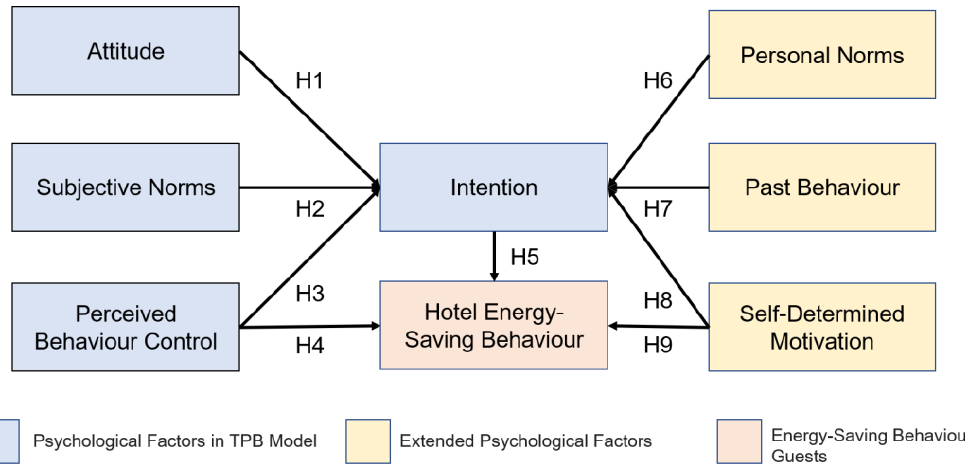
Figure 2. The employed theoretical model and hypotheses in extended model